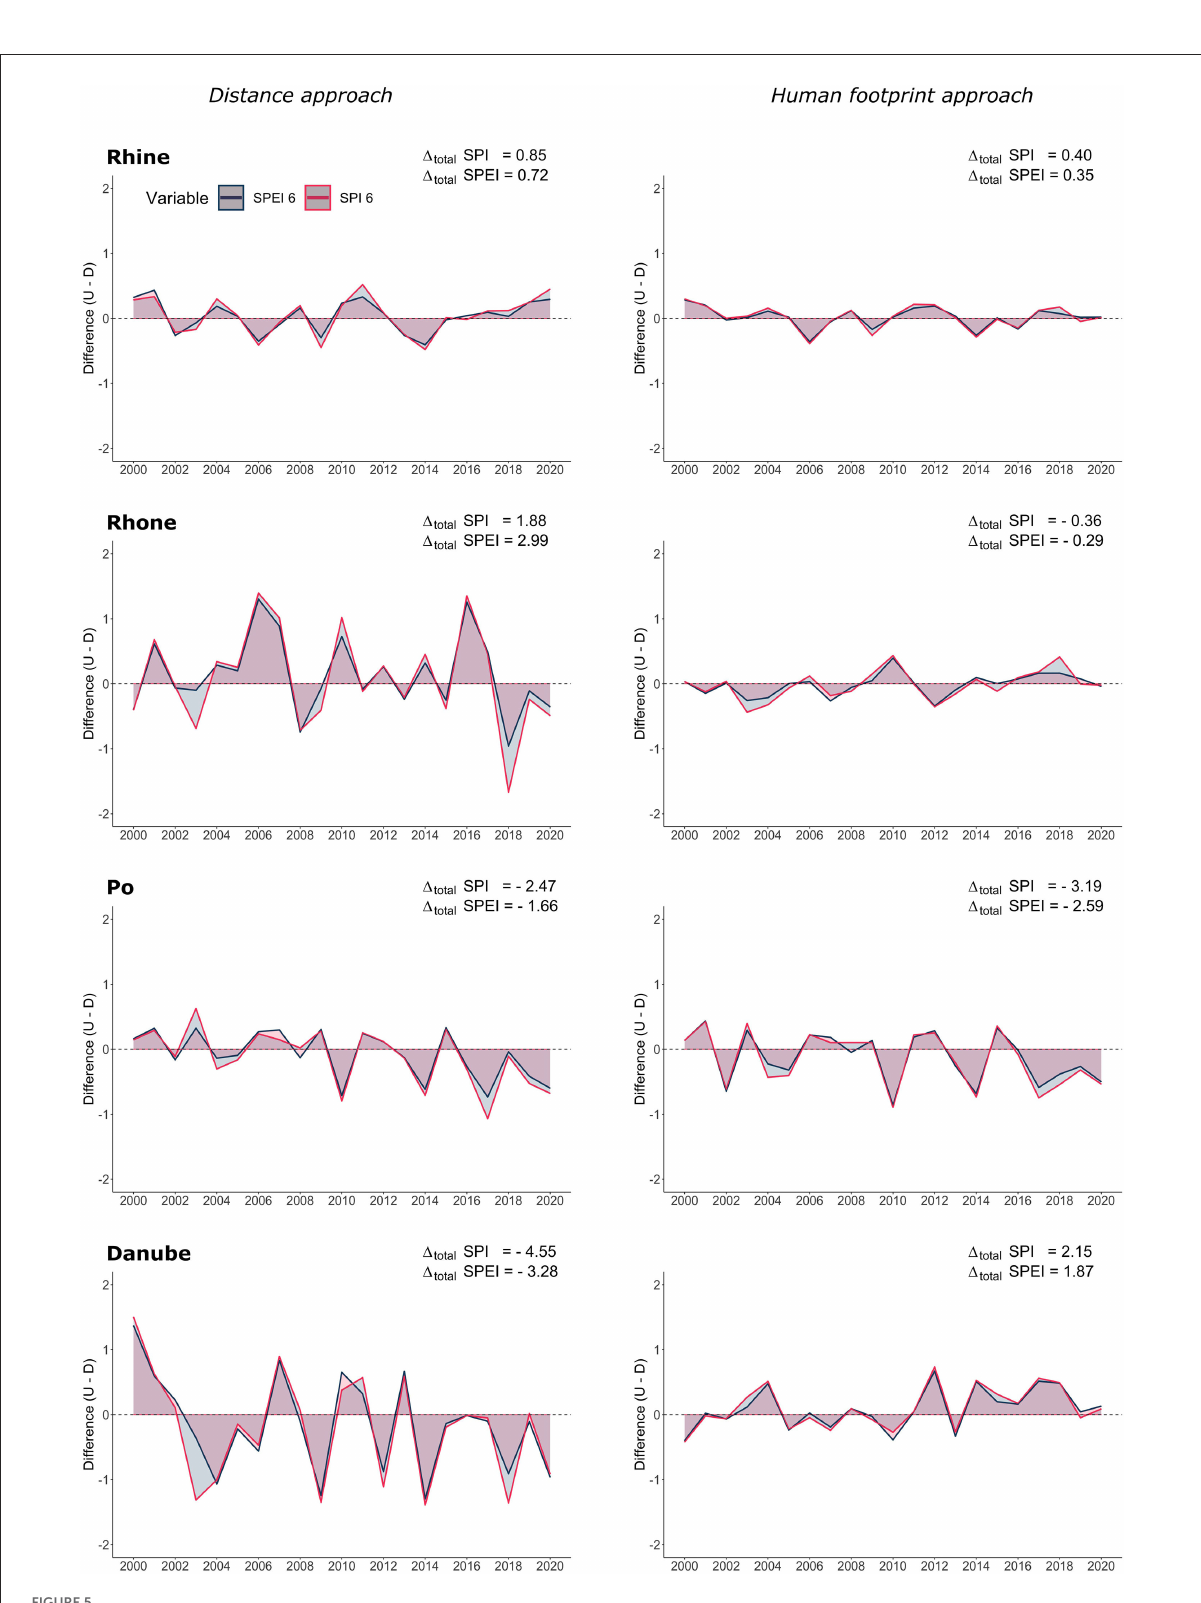
FIGURE5 Upstream-downstream differences of the SPI-6 and SPEI-6 values within the four basins; values < 0 indicate that drought conditions are more severe in the upstream